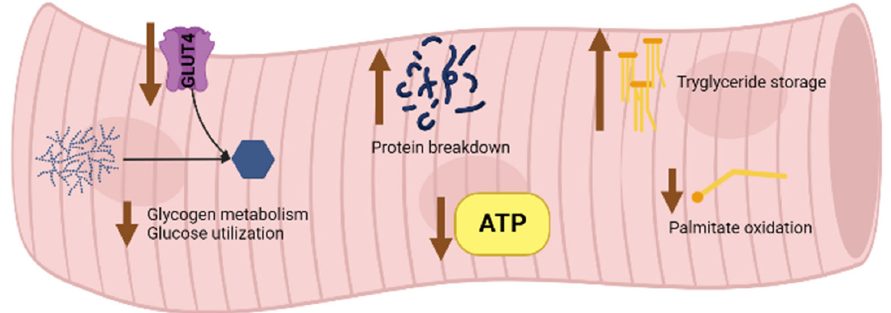
Figure 1. Age ‐ associated altered metabolism in skeletal